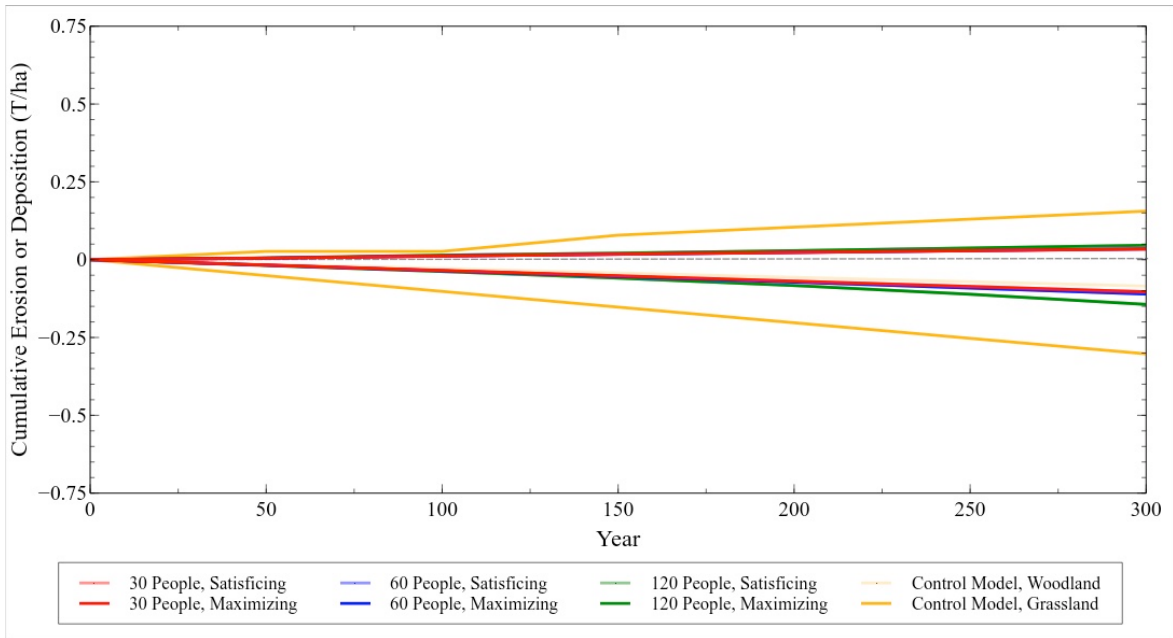
Figure 10. Cumulative amount of sediment eroded or deposited (tons/ha) on hillslopes for each of the six experiments and two control runs during the 300-year modeling interval. Values are averaged across the 40 repetitions of each experiment. The cumulative tons/ha of eroded sediment are shown below the center lines of each graph, and cumulative tons/ha of deposited sediment are above the center lines for the 300 year modeling interval. We show erosion and deposition separately because sediment removal and accumulations often happen in different landscape contexts, with different consequences for agropastoral and other